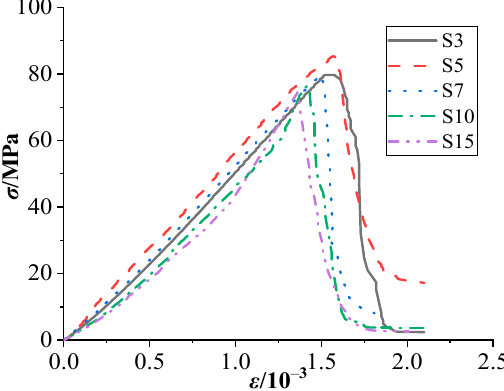
Figure 14. Stress–strain curves of concrete with different stone powder contents.